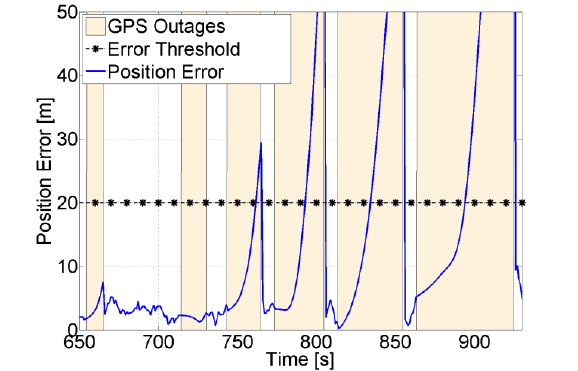
Figure 22. Position uncertainty during GPS total outages.